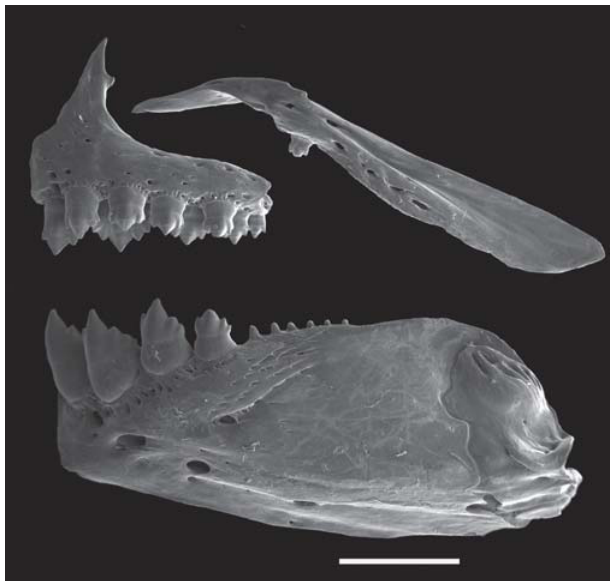
Fig. 2. Astyanax jordanensis , MCP 41915, paratype, 44.3 mm SL. Scanning electronic microscopy of left side of upper and lower jaws. Scale bar = 1